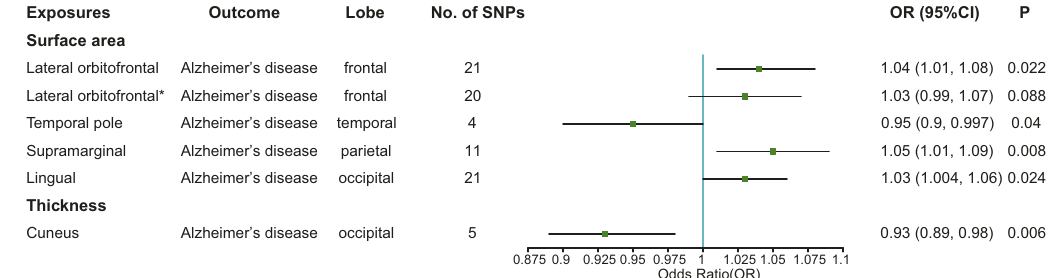
Fig. 2 The causal effect of genetically predicted cortical structure on Alzheimer ’ s disease. SNP single-nucleotide polymorphism, OR odds ratio genetically predicted 1-SD unit increase in the cortical thickness, CI con fi dence interval, IVW inverse-variance weighted.